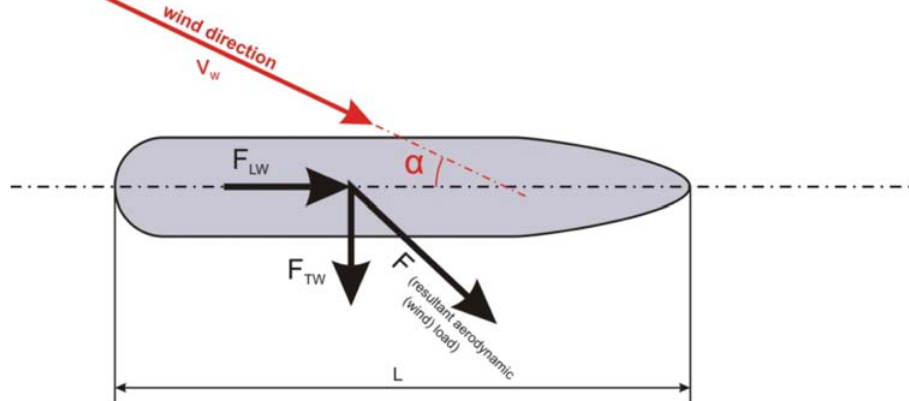
Fig. 12. Aerodynamic loads on ships (BS 6349-4: